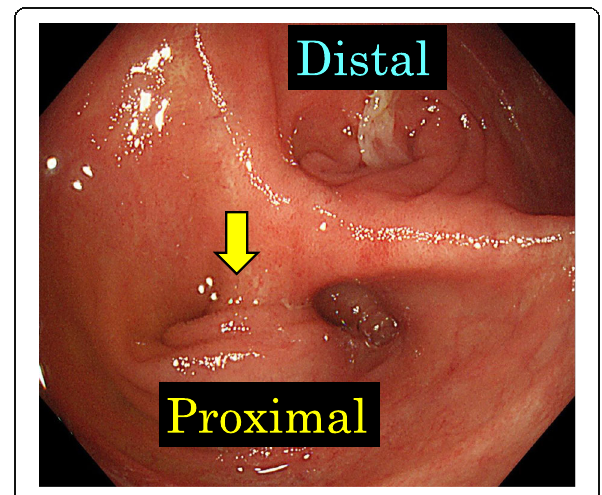
Fig. 5 Endoscopy (ES-5) showed a sharp angulation at the inlet of the ileal pouch, and the proximal side could not be overlooked (yellow